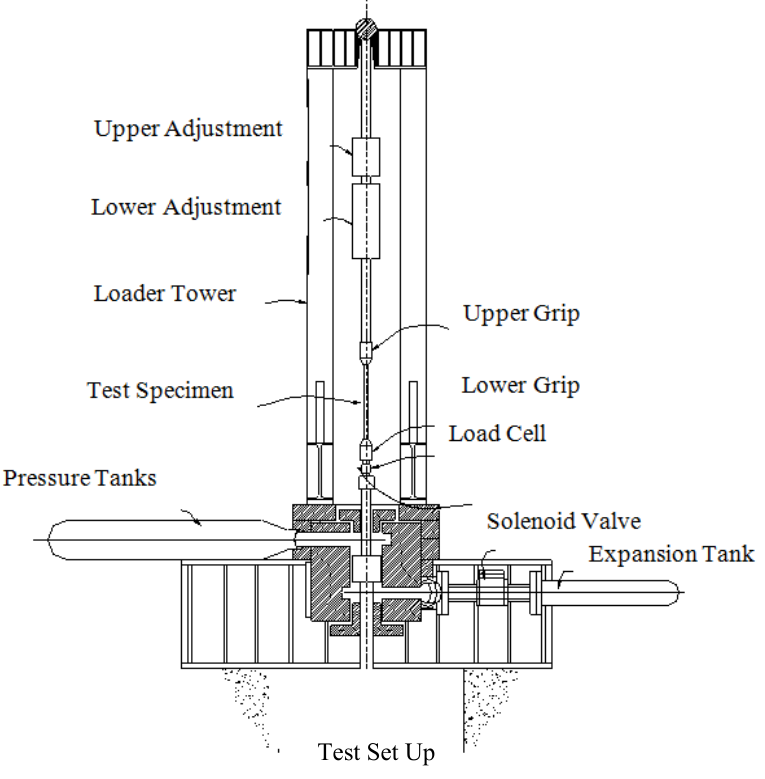
Figure 4. Schematic 890 kN Dynamic